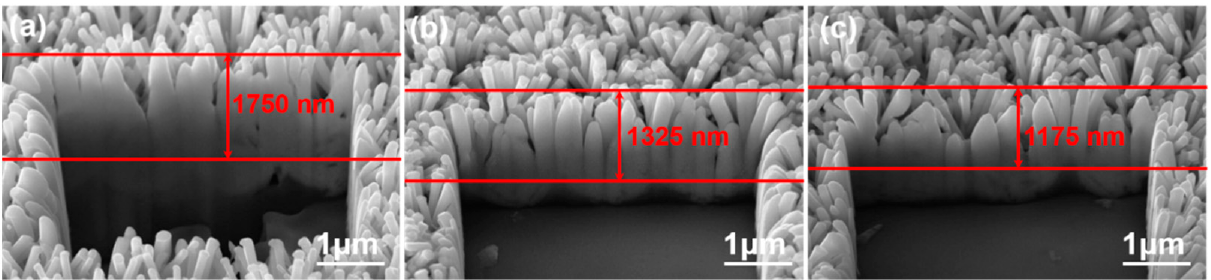
Figure 8. Cross-sectional SEM images of the ZnO nanoflower arrays on Al sacrificial layers of different thicknesses: ( a ) 120, ( b ) 420, and ( c ) 720 nm.